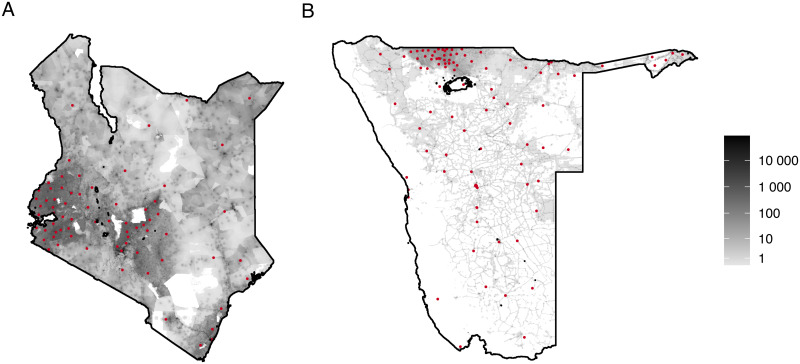
Population density per ∼1km2.Population counts are plotted on a grey log-scale by spatially aggregating ∼100 × 100 m level data obtained from WorldPop [33, 34]. Red dots represent population-weighted centroids for the administrative unit level.